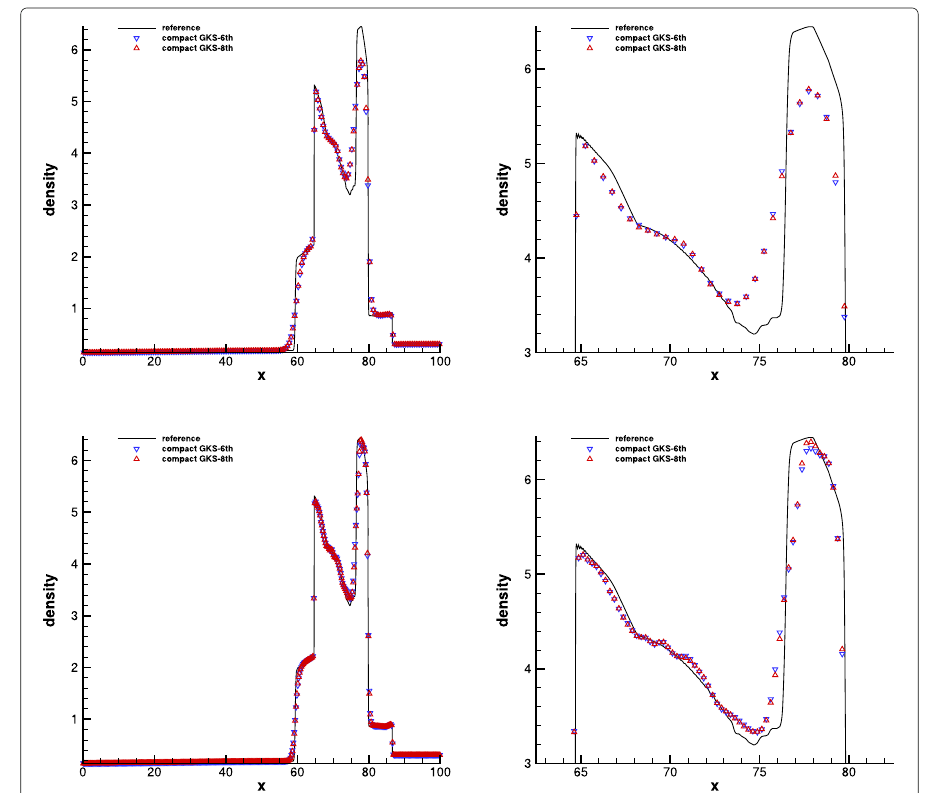
Fig. 7 Blast wave problem: the density distributions from 6th-order and 8th-order compact GKS at t = 3.8 with 200 (up) and 400 (down) mesh points